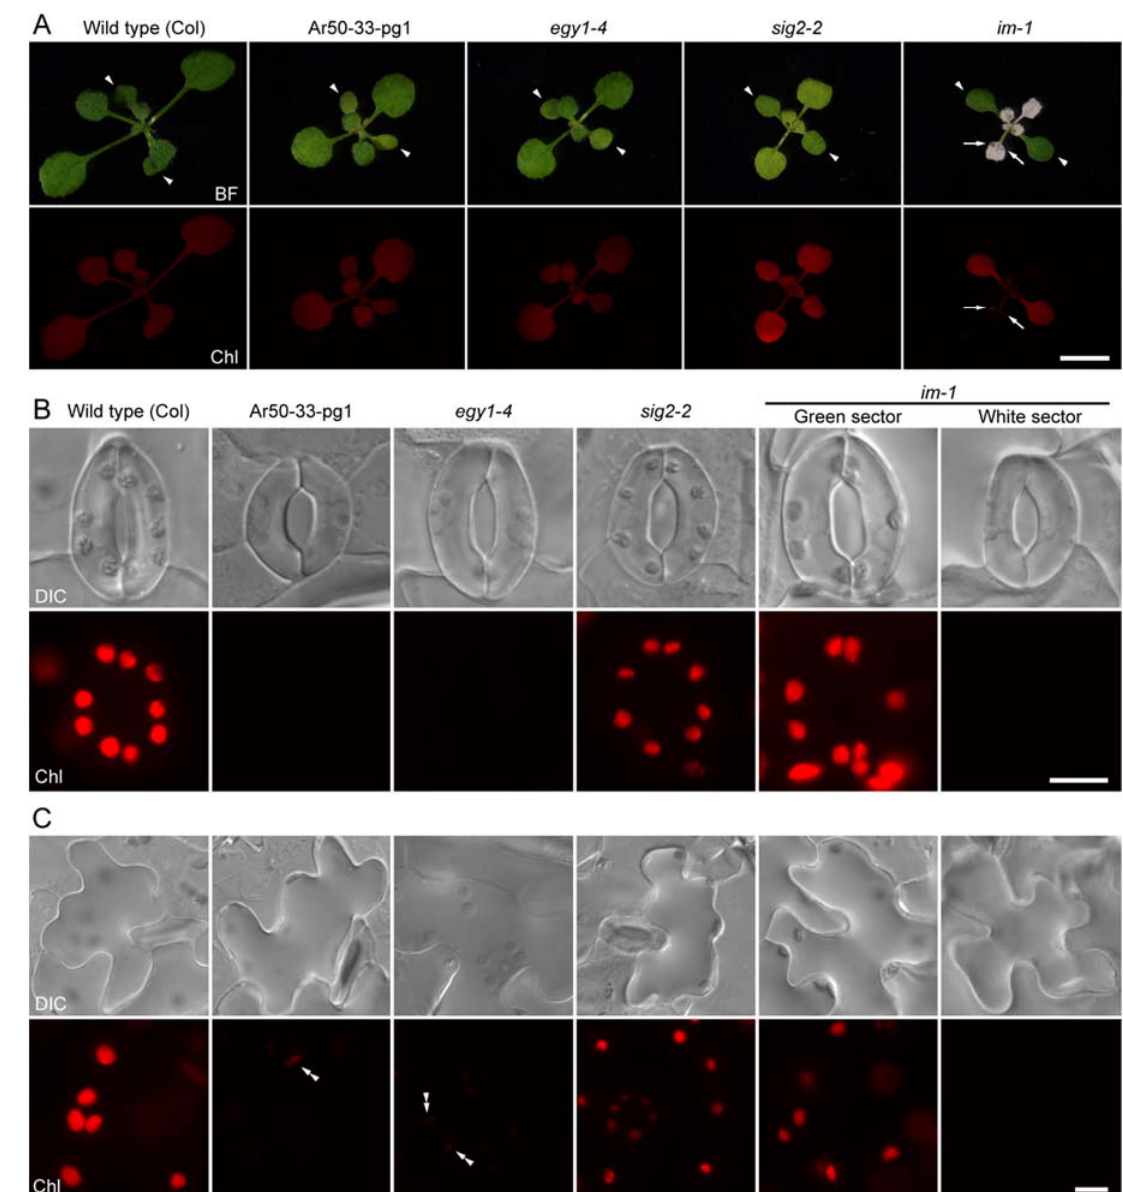
Figure 1. Fluorescence microscopy of the epidermis of fully expanded leaves of wild-type and mutant plants. ( A ) Photographs of 2-week-old wild-type (Col), Ar50-33-pg1, egy1-4 , sig2-2 , and im-1 seedlings grown in soil. Arrowheads and arrows indicate cotyledons and green sectors in variegated leaves, respectively. ( B , C ) Differential interference contrast (DIC) and chlorophyll autofluorescence (Chl) images of guard cells ( B ) and pavement cells ( C ) in the abaxial leaf epidermal peels of the primary leaves of 3-week-old seedlings. Double arrowheads in ( C ) indicate chloroplasts. Chl images in ( B , C ) were captured under the same microscopic conditions. Bar = 5 mm ( A ) and 10 µ m ( B , C